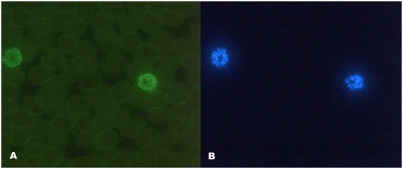
Representative immunofluorescent microscopy picture, showing recognition of native antigen on merozoites by induced anti-AMA1 antibodies.Immunofluorescence picture of merozoites incubated with 40× diluted anti-AMA1 plasma from an immunized volunteer one month after final immunisation stained with Rabbit anti-human immunoglobulin FITC (A) and DAPI (B). Photo was taken at magnification 400×. Incubation with monoclonal antibody 4G2, a pan-specific anti-AMA1 antibody, confirmed the surface staining pattern (not shown).